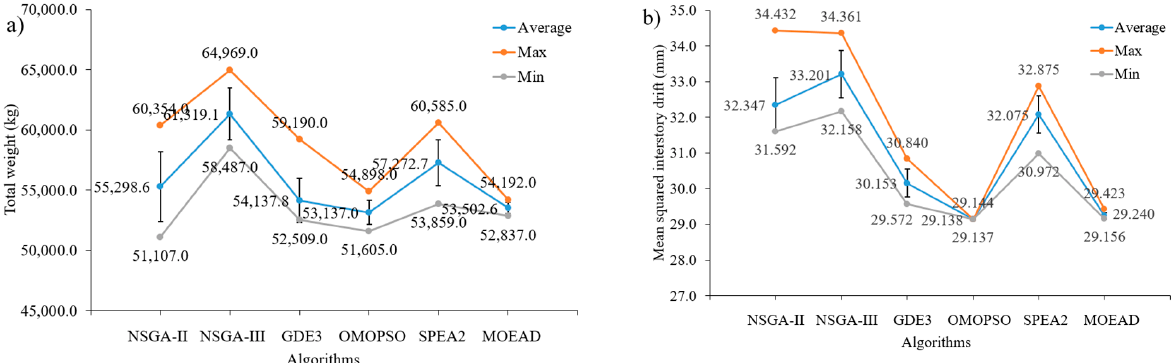
Figure 21. Spread illustration of the optimal solutions in the 113-bar truss bridge regarding the ( a ) first objective; ( b ) second objective.